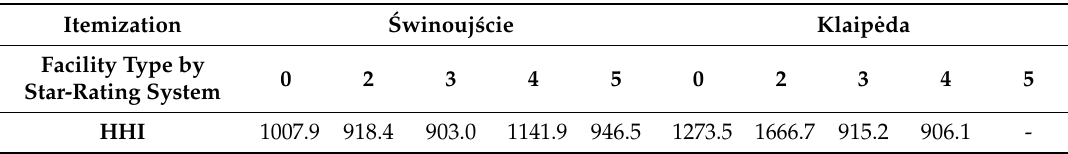
Table 5. Level of concentration of the security measures by the type of accommodation facility measured by Herfindahl–Hirscham